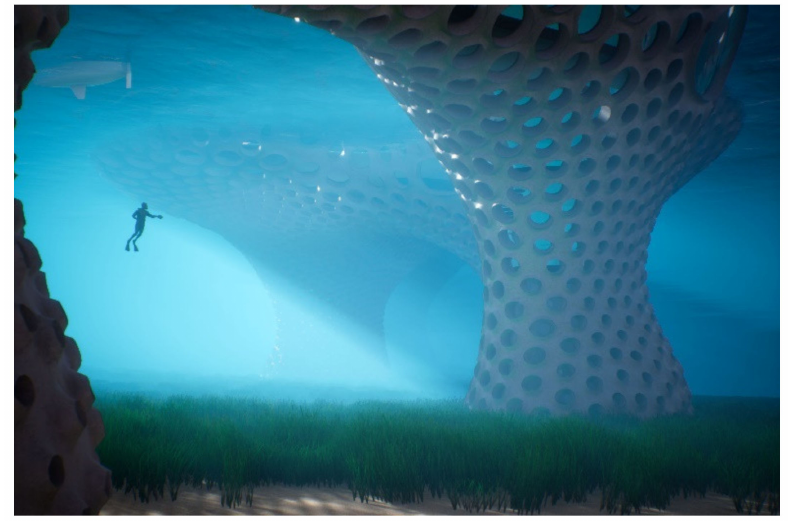
Figure 2. Biolum_Reef (© Treex/Tangram